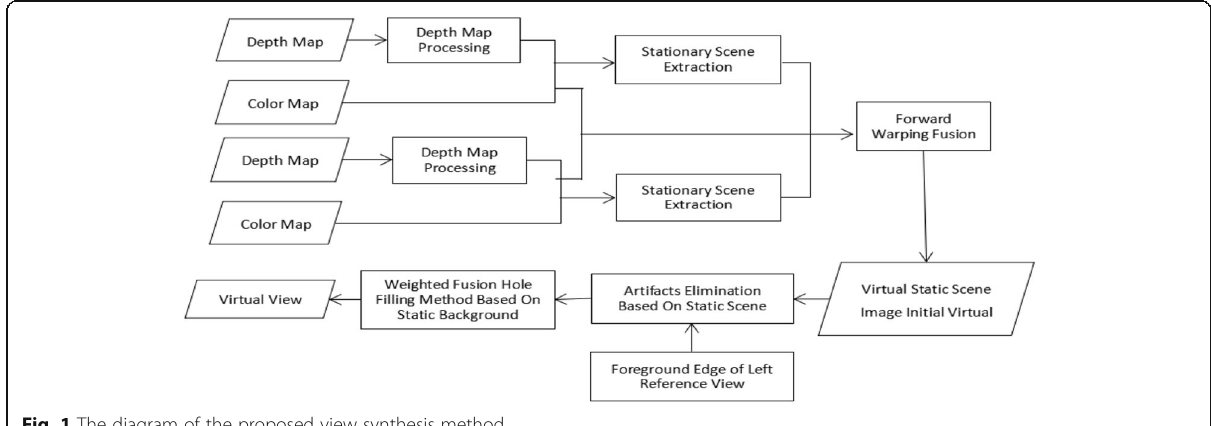
Fig. 1 The diagram of the proposed view synthesis method